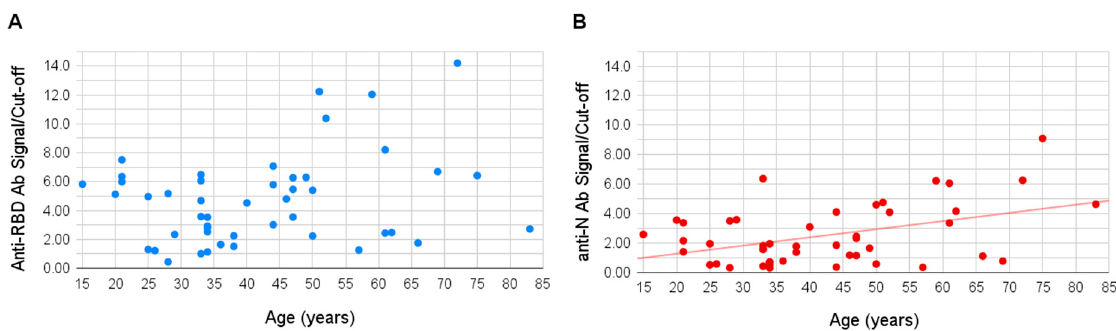
Figure 3. Correlation of patient age with antibody signal. The S/CO to the anti-RBD ( A ) and anti-N ( B ) antibodies are